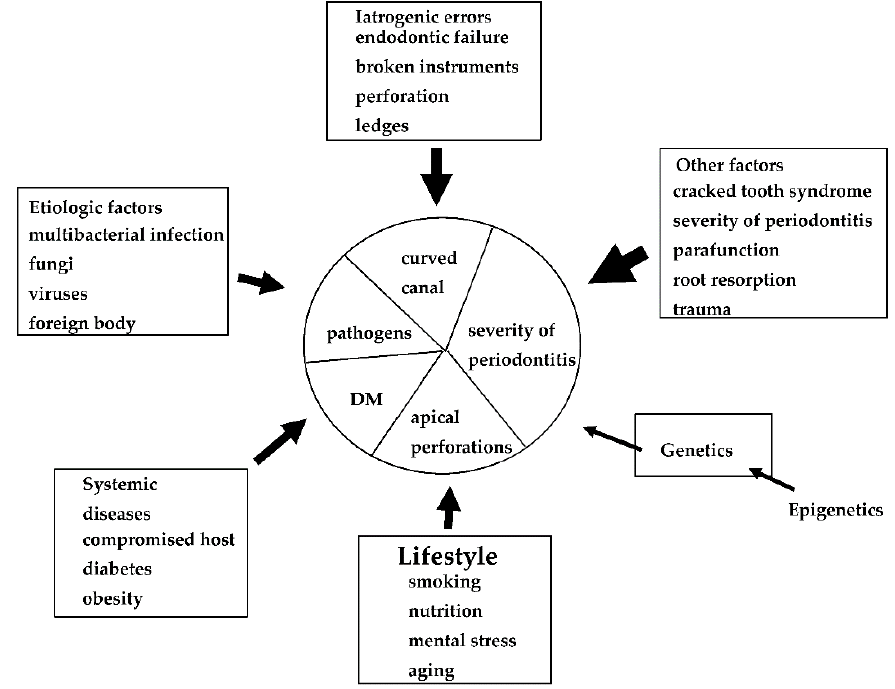
Figure 1. Possible causes, risk factors, and predisposing factors associated with EPLs. These factors may influence the progression and pathogenesis of each EPL.